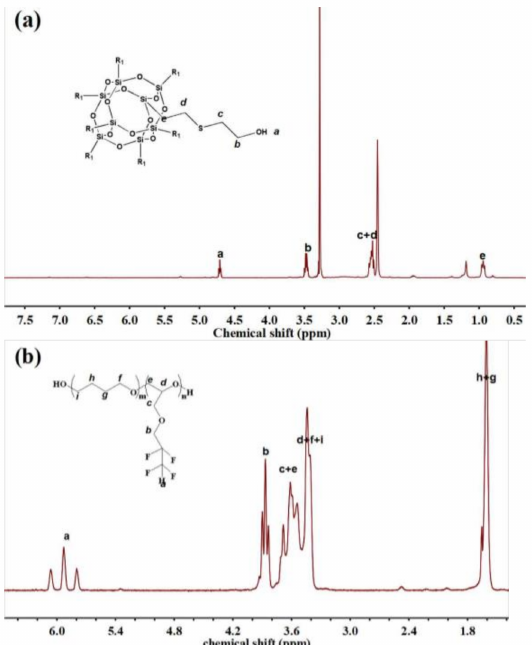
Figure 1. The 1 H NMR spectra of POSS-(OH) 8 ( a ) and P(FPO/THF) ( b ).